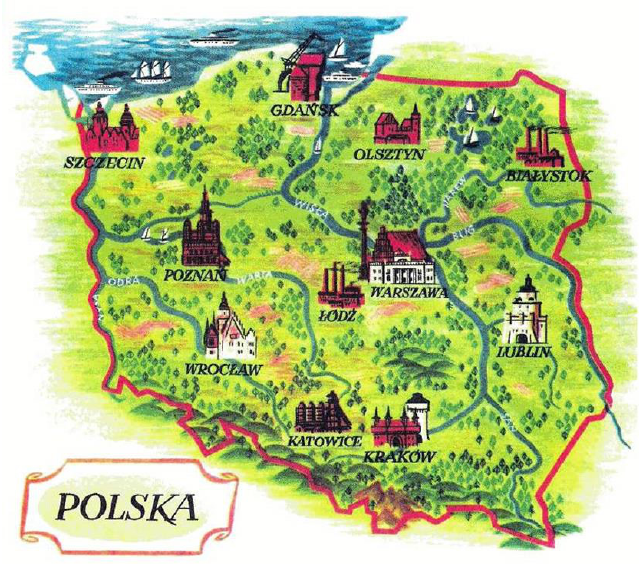
Fig. 3. The map of Poland from Elementarz (reduced, source: M. Falski,